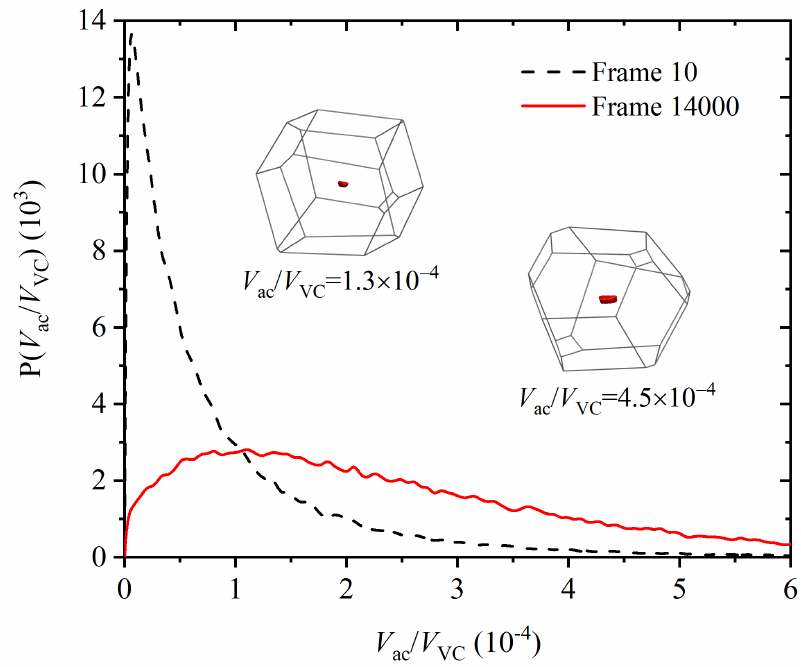
Figure 12. Relative local accessible volume distribution in the amorphous state (black dashed line) and in the crystalline state (red solid line). Relative accessible volume is the ratio of the local accessible volume of a monomer to the volume of the Voronoi cell of the same monomer. The distributions of the absolute accessible volume follow the same trend. Two snapshots of different accessible volumes from sites of the last recorded configuration (frame 1400) are shown as